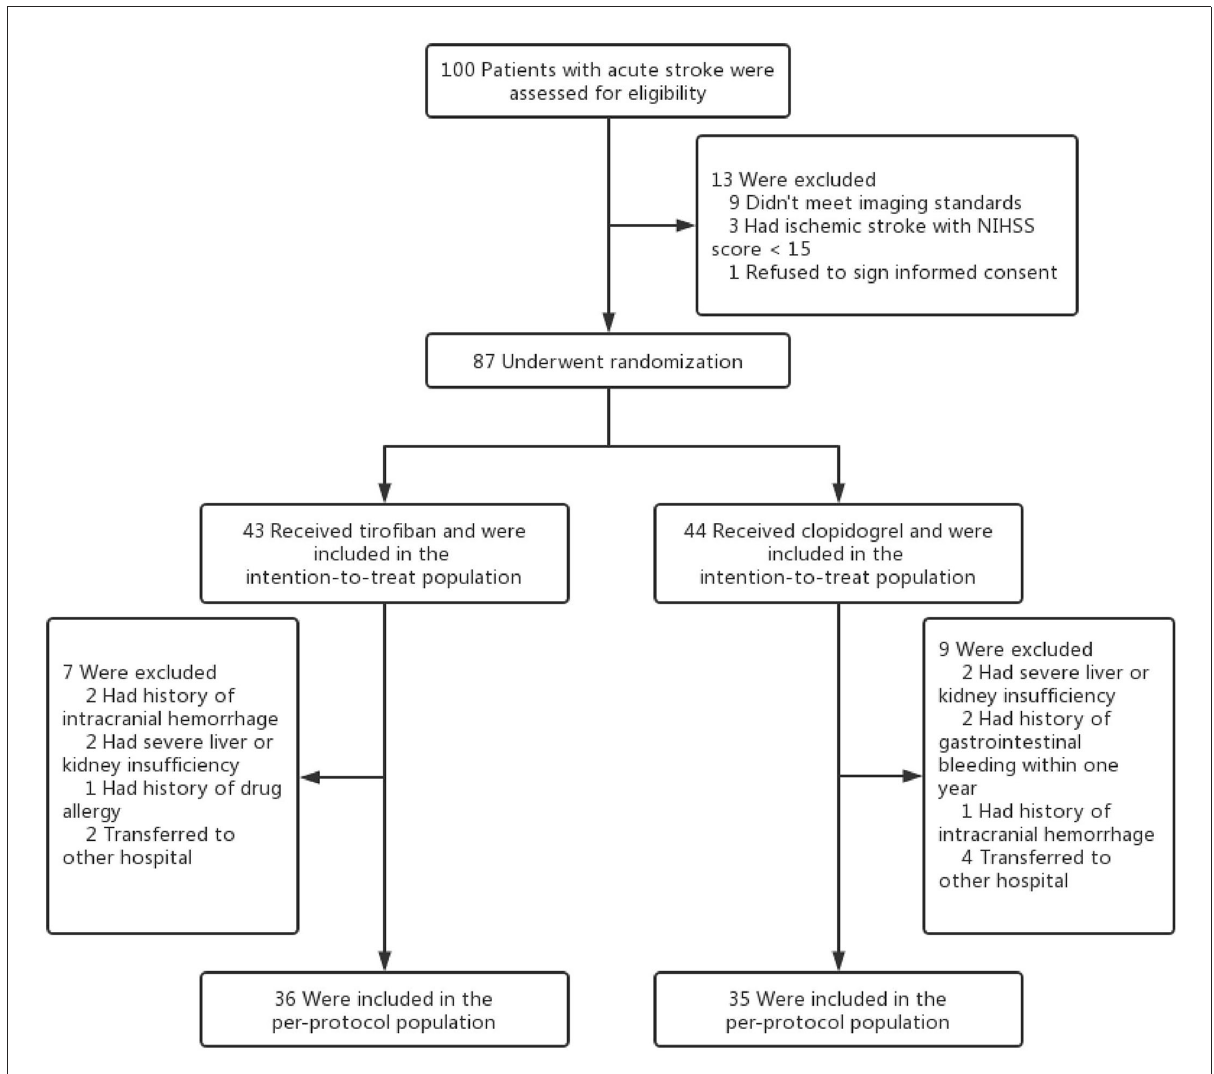
FIGURE1 Flow chart of the